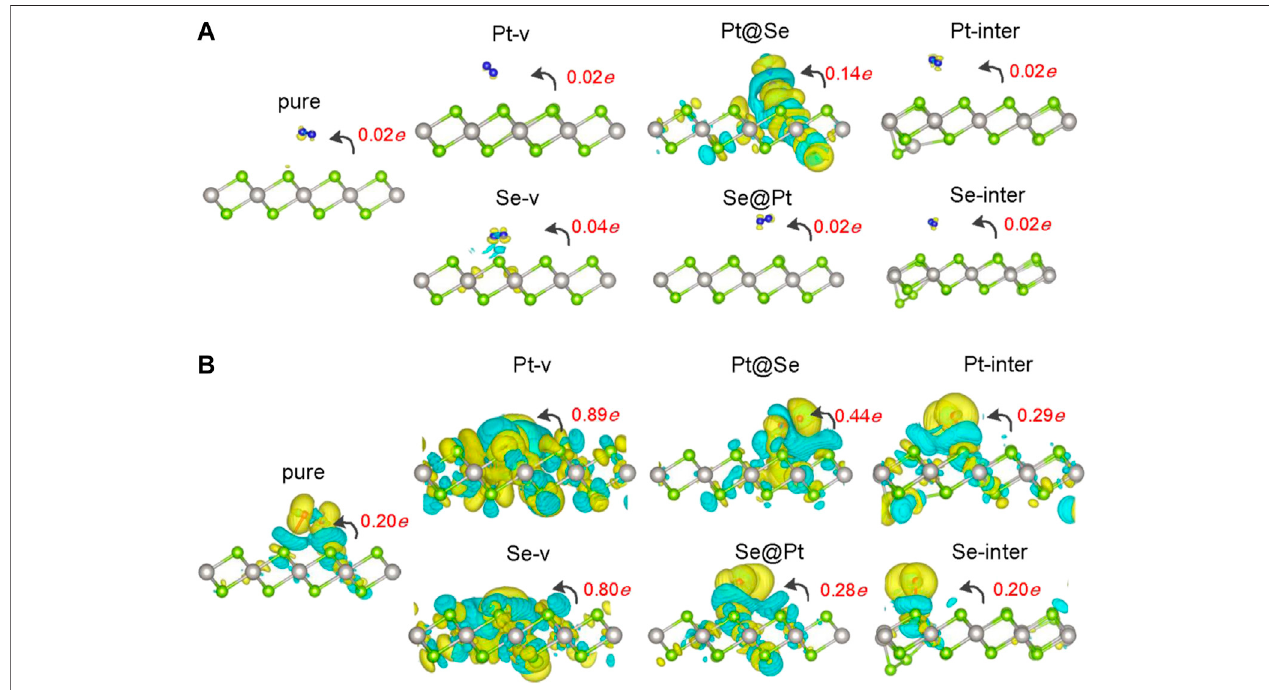
FIGURE 2 | Charge density difference (CDD) for N 2 (A) and O 2 (B) adsorbed pure and defected PtSe 2 . The yellow (cyan) region represents charge accumulation (depletion), and the values of isosurfaces for all the structures are set to 0.0003 e /Å − 3 . The red numbers indicate the values of Bader charges on the molecules, and the black curved arrows indicate the orientation of charge